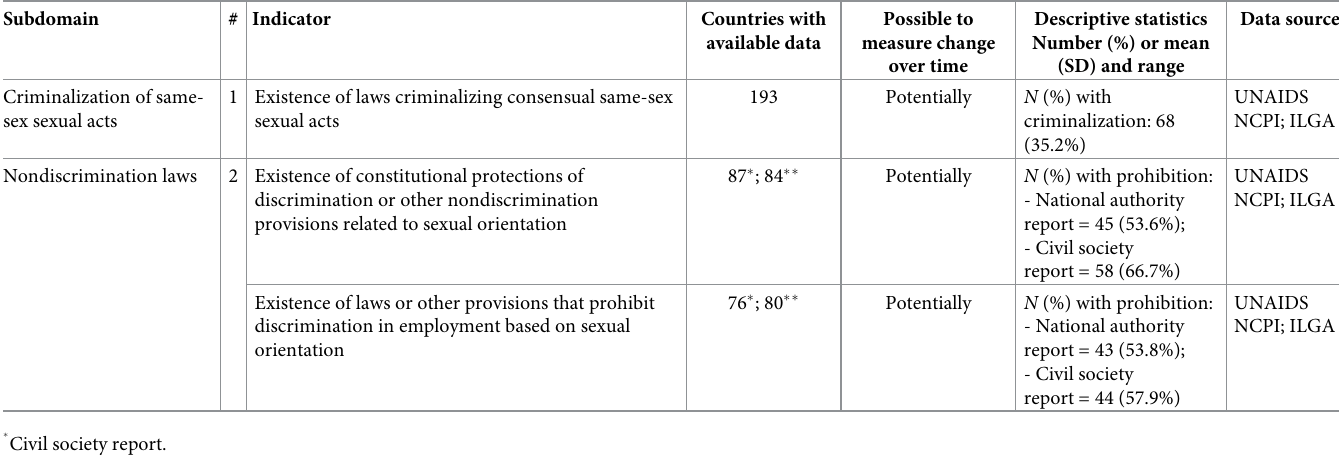
Table 3. Final indicators for sexual behavior/orientation stigma related to men who have sex with men. Subdomain